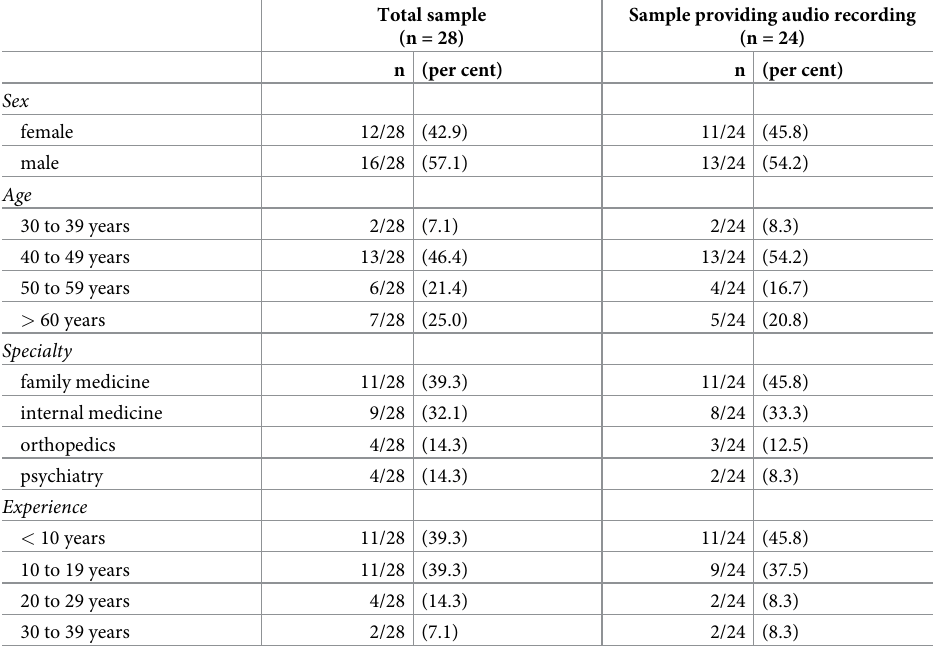
Table 1. Characteristics of participating